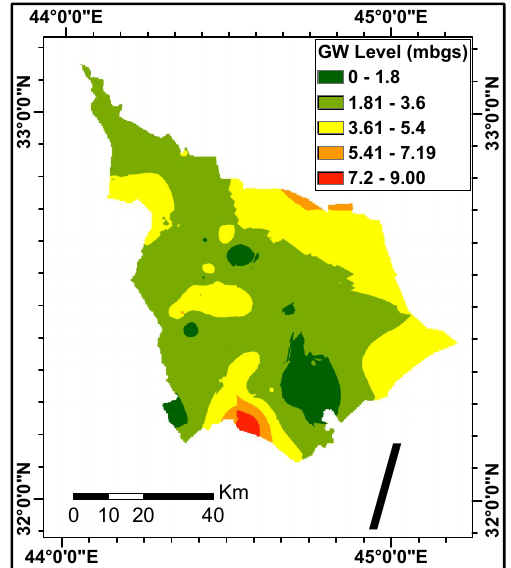
Figure 4. Babylon province groundwater level.